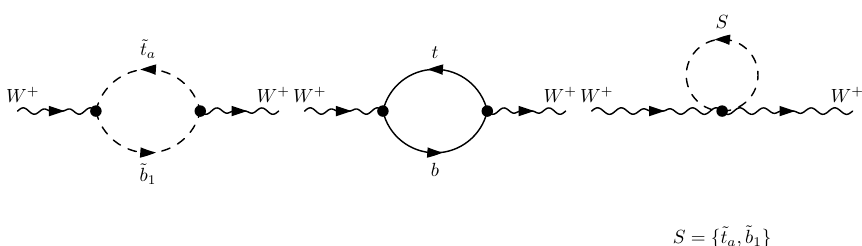
Figure 5 . Generic one-loop self-energies of the W boson contributing at O ( (cid:11) t ) to the renormal- ization of v . A summation over the index a = 1 ; 2 of the internal stops is implicit.